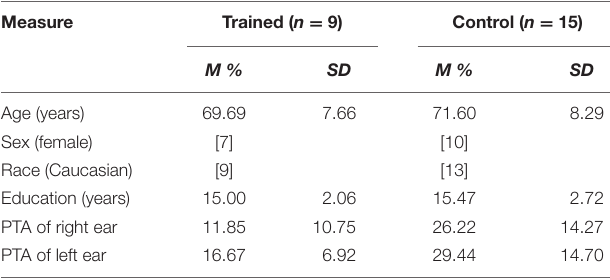
TABLE 1 | Summary statistics for participants by